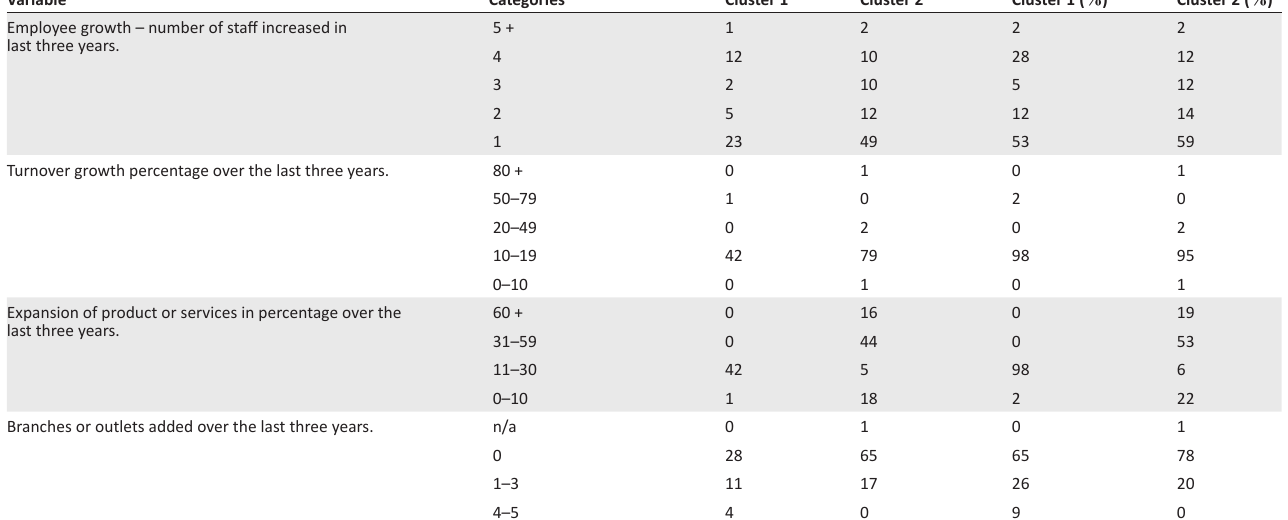
Turnover growth percentage over the last three years.